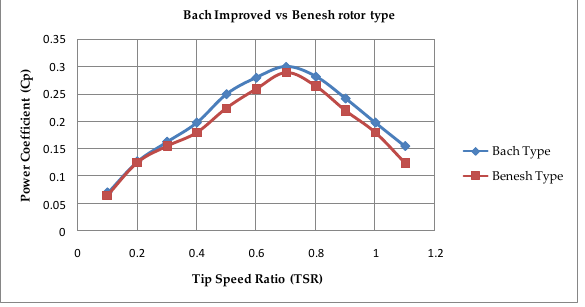
Figure 4. Experimental results for power coefficient (Cp) function of tip speed ratio (TSR) for Bach and Benesh rotor models.